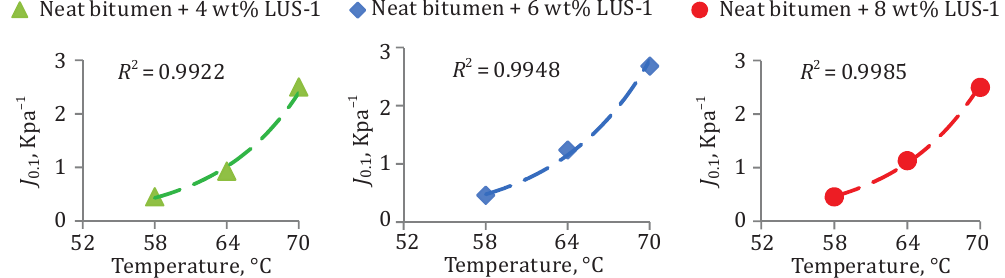
Figure 6. The correlation between temperature and J 0.1